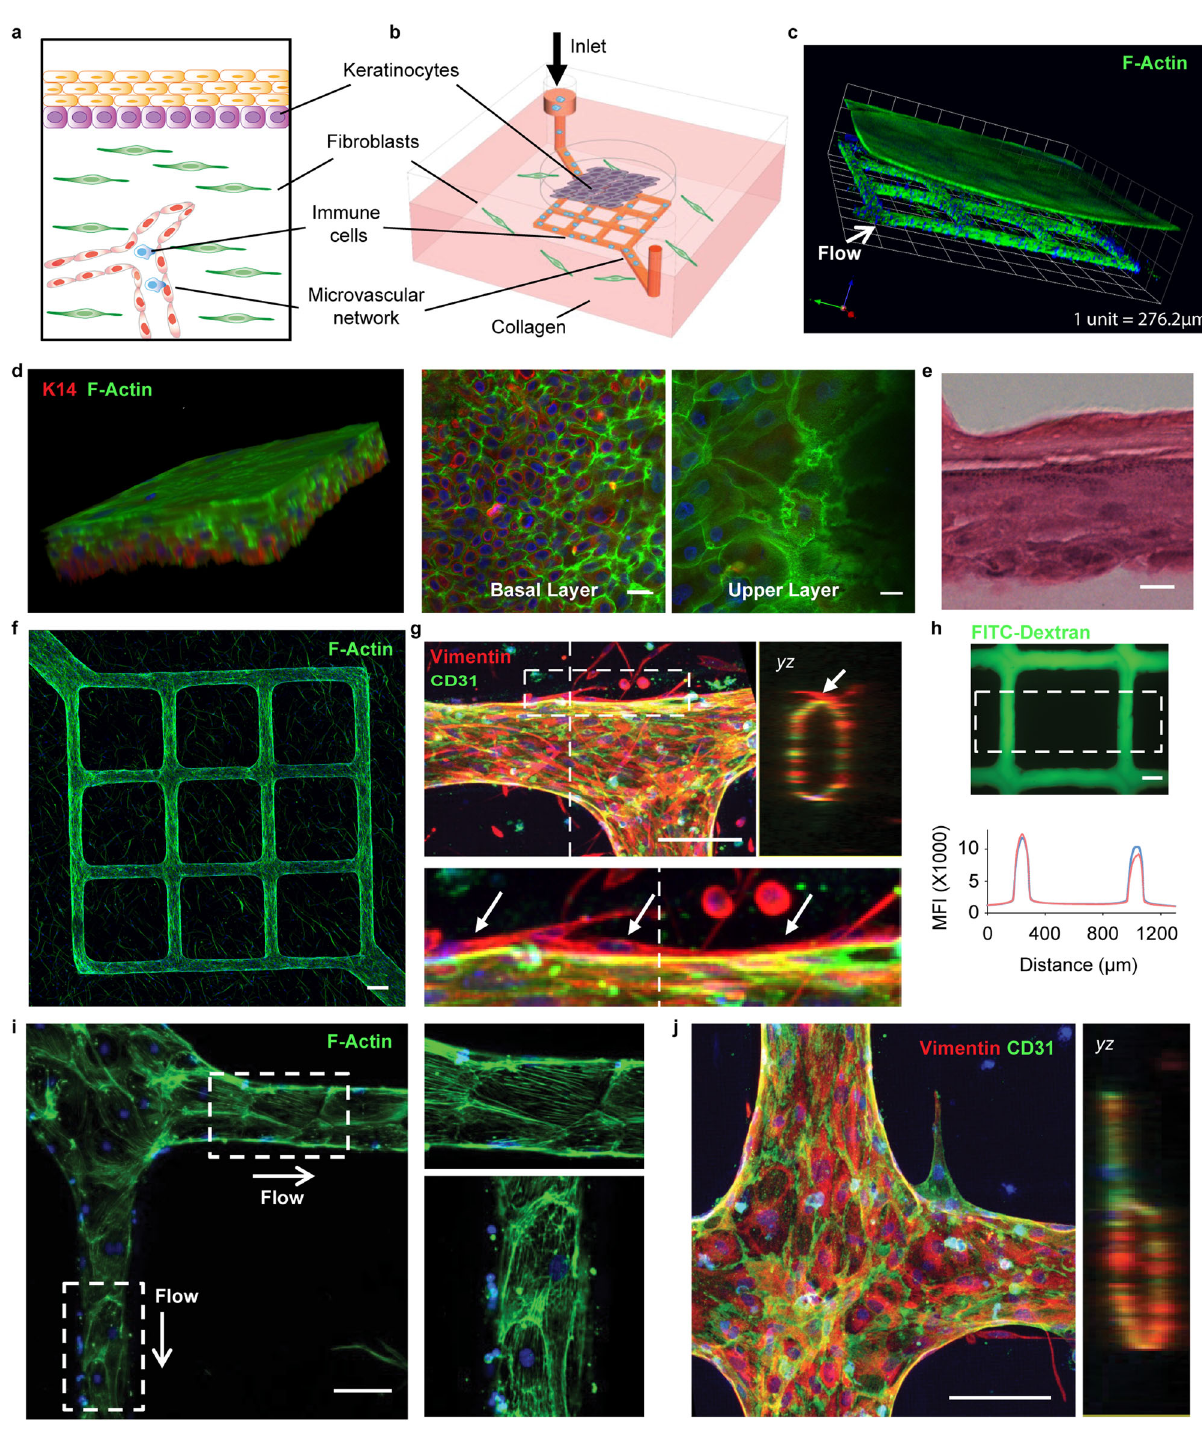
Fig. 1 | Skin-on-chip contains a strati fi ed epidermis and dermis with a func- tionalmicrovascularnetwork.a , b Schematicsofthemajorcomponentsinnative human skin and skin-on-chip. c Representative 3-D reconstructed confocal image showing an overview of the cytoskeleton of the micro-engineered epidermis and dermis with underlying endothelialized microvascular network (white arrow indi- catesmicro fl uidic fl owdirection).F-actinforcellcytoskeleton(green),DAPIforcell nucleus (blue). d Representative 3-D reconstructed confocal image illustrating basale (bottom, K14 + ) and corneous (upper, anucleate) layers in the epidermis of skin-on-chip. F-actin (green), K14 (red), DAPI (blue). Scale bar: 20 µ m. e A cross- sectional view of hematoxylin – eosin (H&E) stained epidermis in the skin-on-chip. Scale bar: 20 µ m. f Maximum intensity projected confocal image of an endothe- lialized microvascular network in the dermis after two weeks of culturing. F-actin